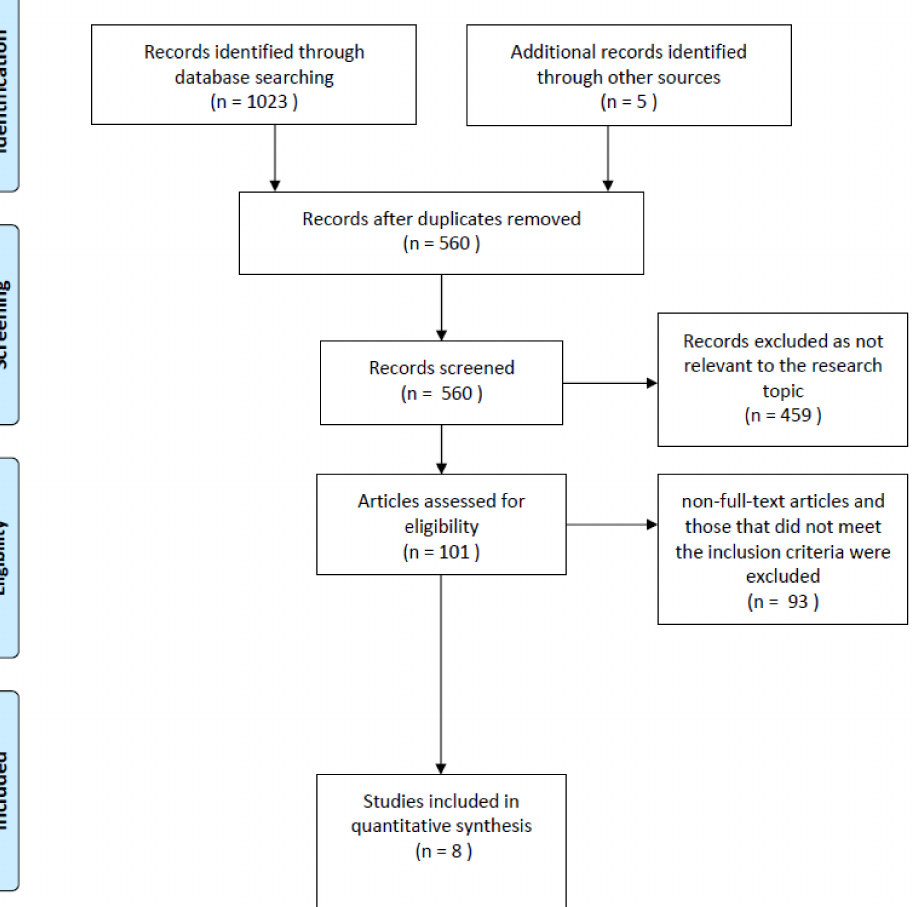
Figure 2. Flowchart of the literature search and selection